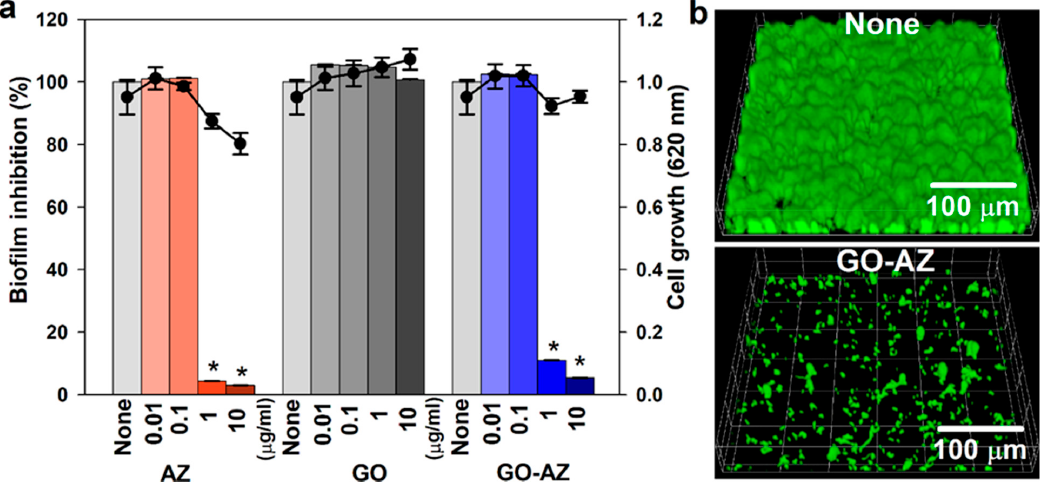
Figure 2. Antibiofilm activity of AZ, GO, and GO-AZ at 0.01–10 µg/mL against C. albicans incubated